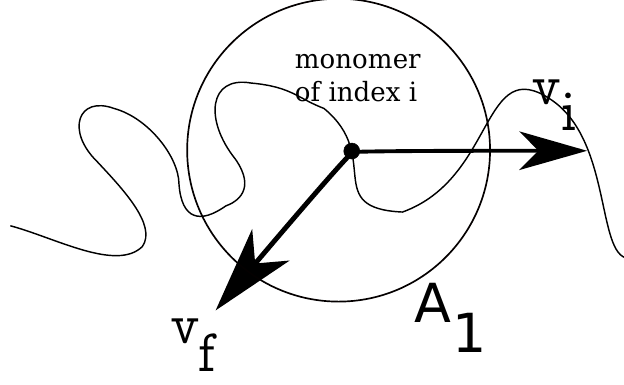
Figure 2. Schematic illustration of fluid control volume, A a charged chain, which has instantaneous velocity ⃗v of monomer i is noted ⃗v f